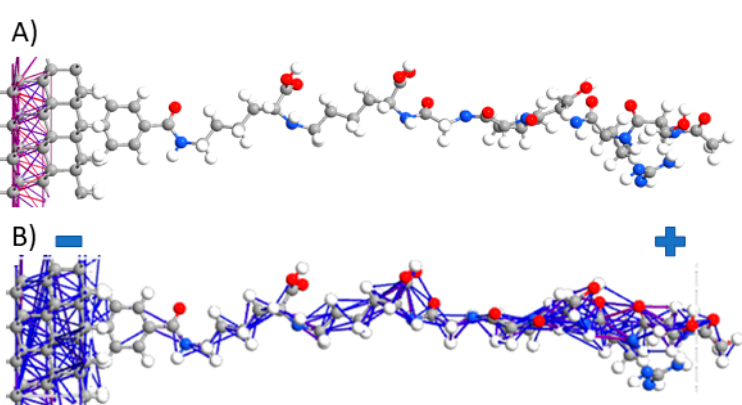
Figure 5. Electron pathways at the diamond surface with attached ligand through linker: ( A ) structure not polarised with potential, ( B ) structure polarised with − 1V potential ( − 0.5V on the left ( − ) and 0.5V on the right side ( + ) of the slab). The 2-terminal device structure was used (attn. electrodes are not shown here for figure readability).